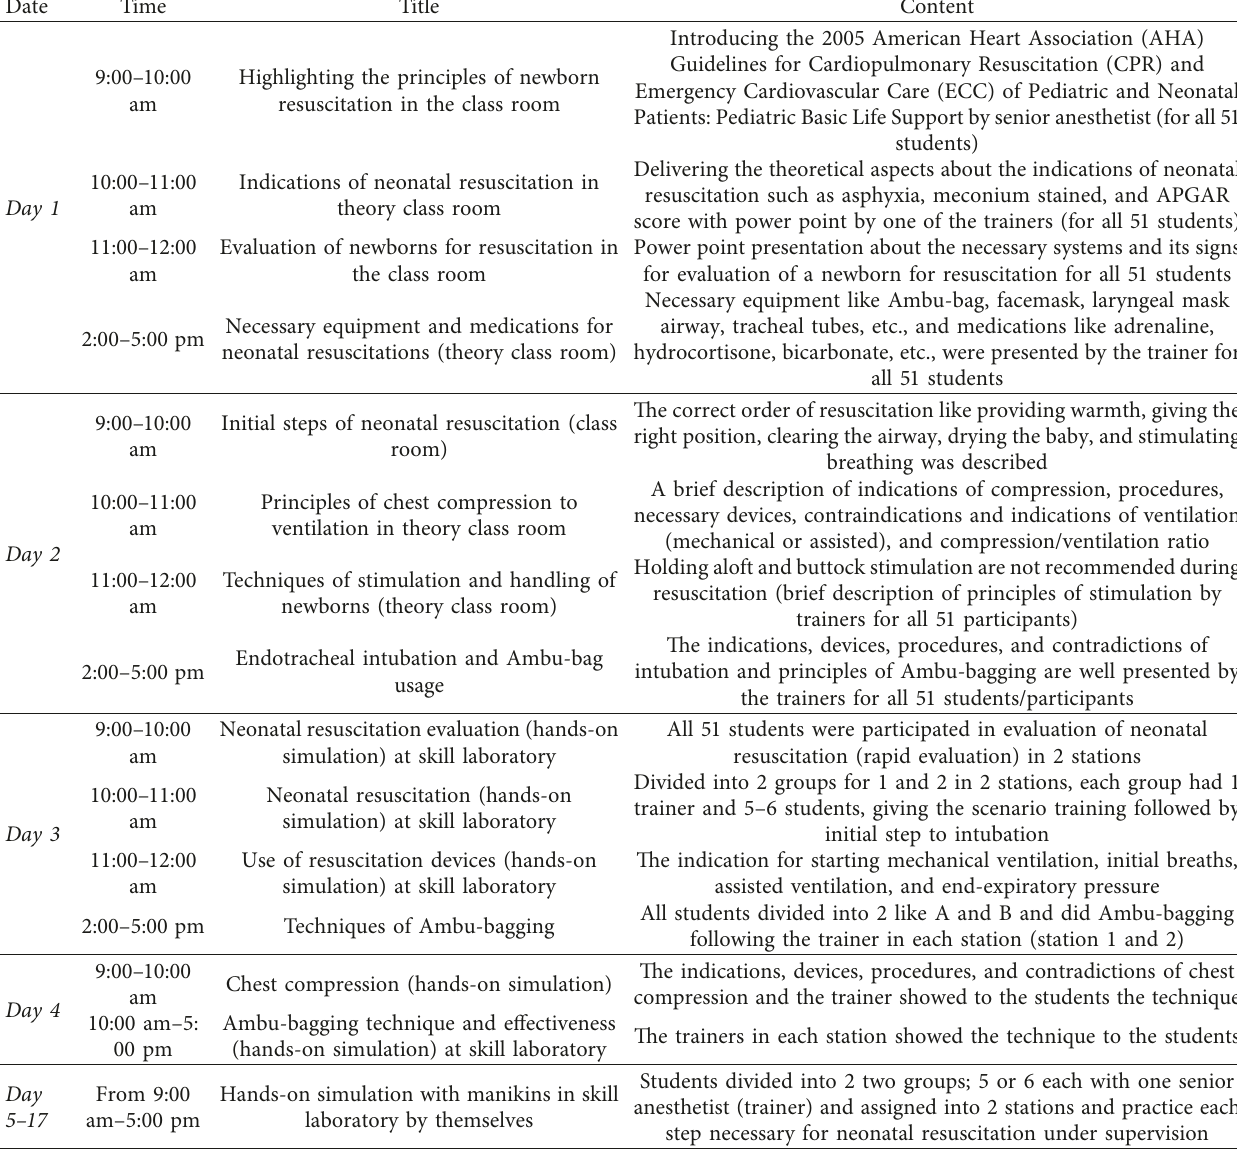
Table 3: Content/curriculum of simulation-based neonatal resuscitation training for undergraduate final-year anesthesia students at a comprehensive specialized teaching referral hospital in